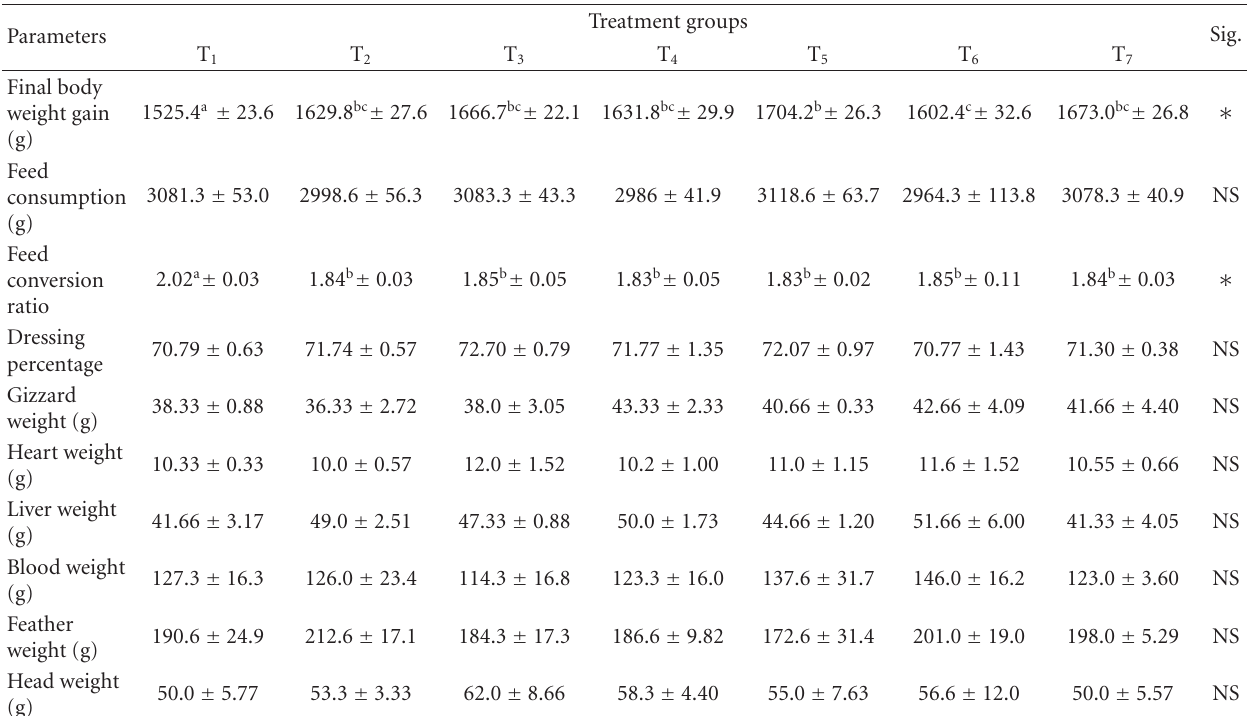
Table 2: E ff ect of organic acid supplementation on the performance and carcass characteristics of broiler chicken. Parameters